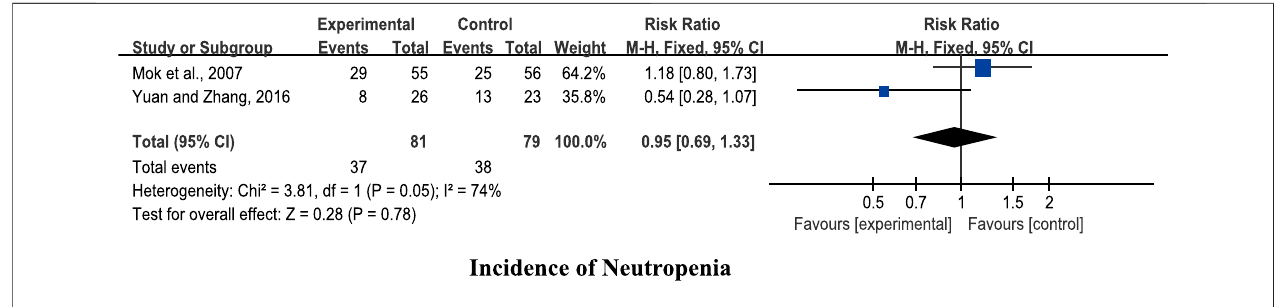
FIGURE 3 | Forest plots of CHM + chemotherapy vs. PBO +